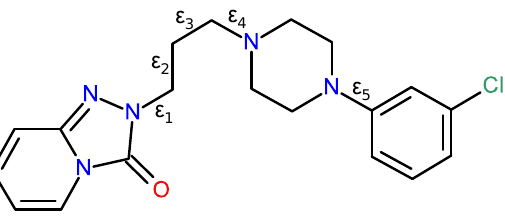
Figure 1. Chemical structure of trazodone with key torsion angles indicated.